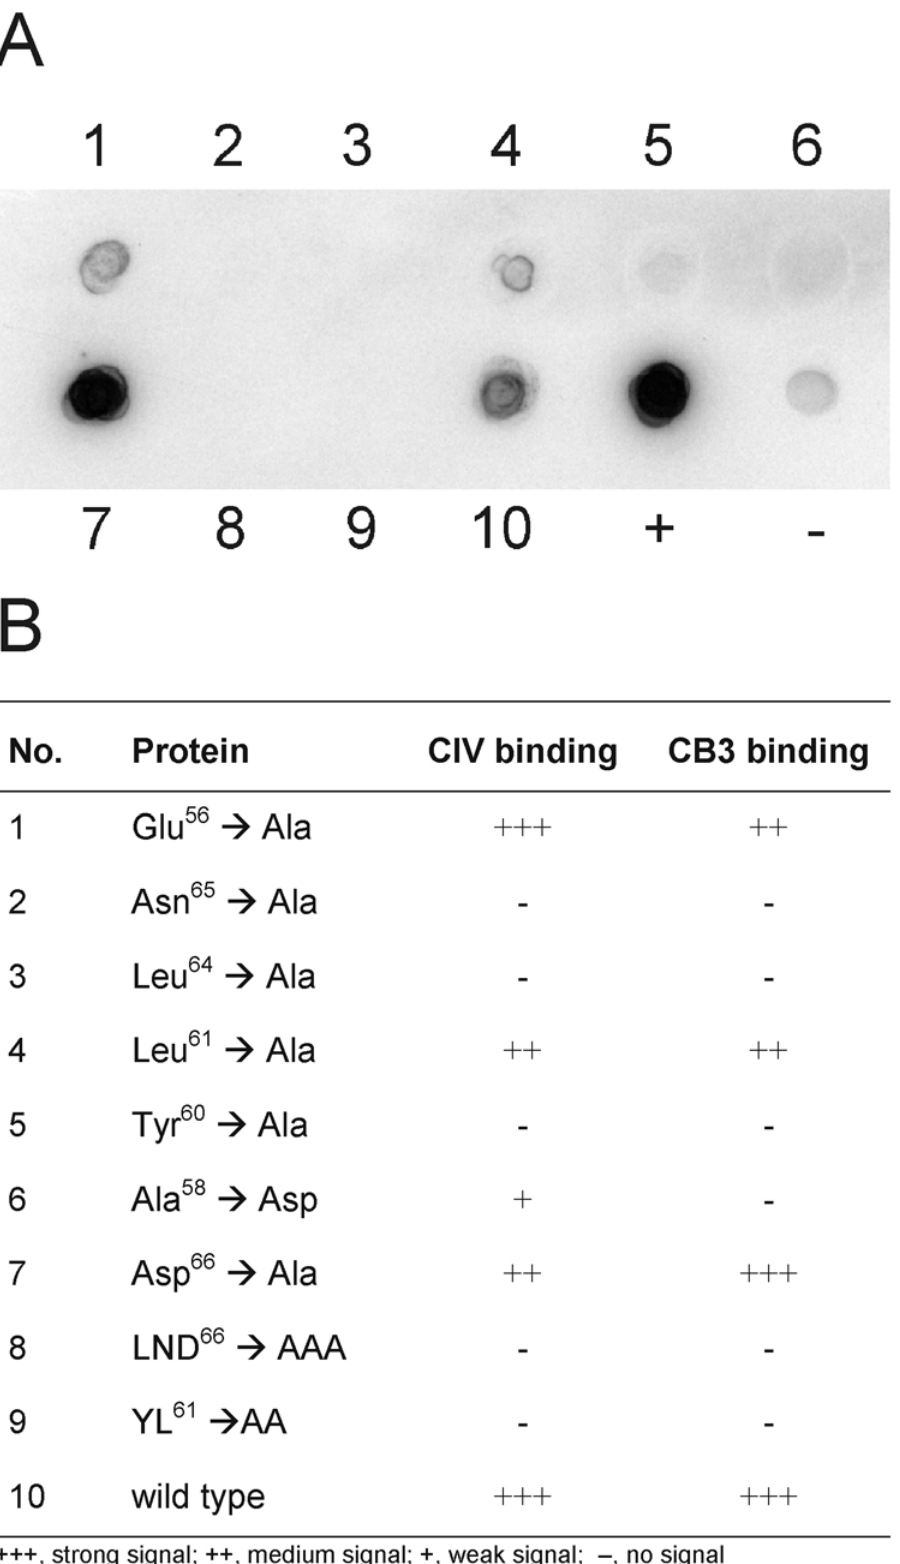
Figure 3. Binding of PARF mutants to CB3. ( A ) Dot blot experiment with 125 I-CB3 as the soluble ligand. Dots 1–9 are the immobilized mutants of M protein FOG (for description see table in B ); dot 10 is recombinant wild type protein. Recombinant M3- ( + ) and M18-proteins ( 2 ) were used as positive and negative control, respectively. The table in B allows to compare the experiment with previous data on full length collagen IV[5].